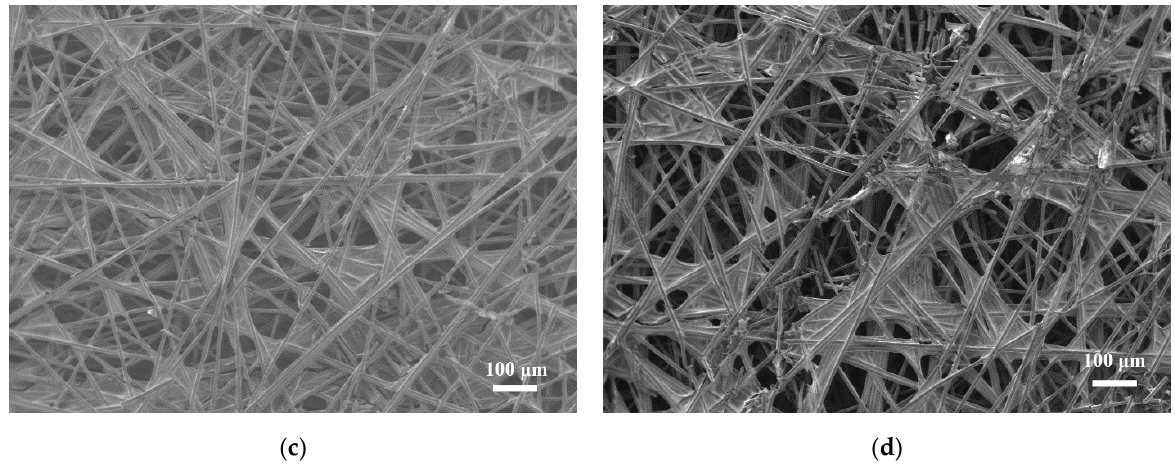
Figure 8. Surface SEM images after 30 freeze/thaw cycles for: ( a ) MPL of cell-4; ( b ) MPL of cell-1; ( c ) GDL of cell-4 and ( d ) GDL of cell-1.